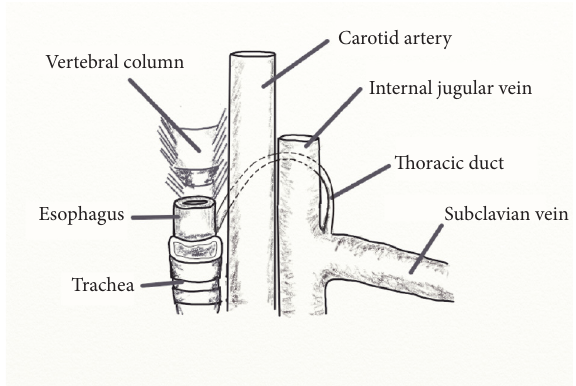
Figure 2: Cervical course of the thoracic duct. The thoracic duct enters the neck lateral to the esophagus, ascending superiorly and laterally behind to the carotid and internal jugular vein before turning inferiorly and anteriorly to join the venous circulation at the confluence of the internal jugular vein and subclavian